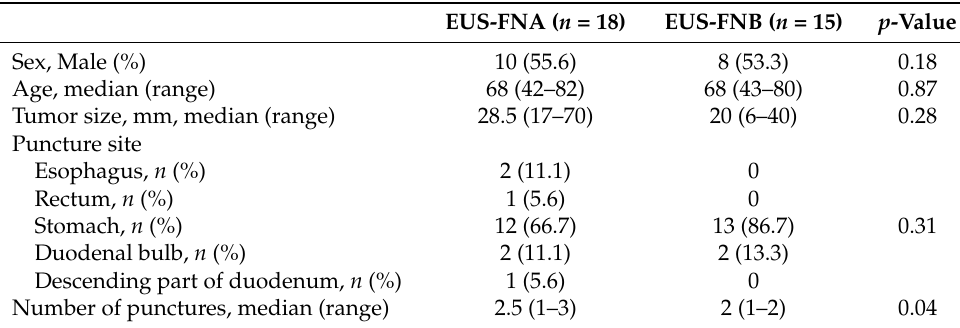
Table 3. Subgroup analysis of